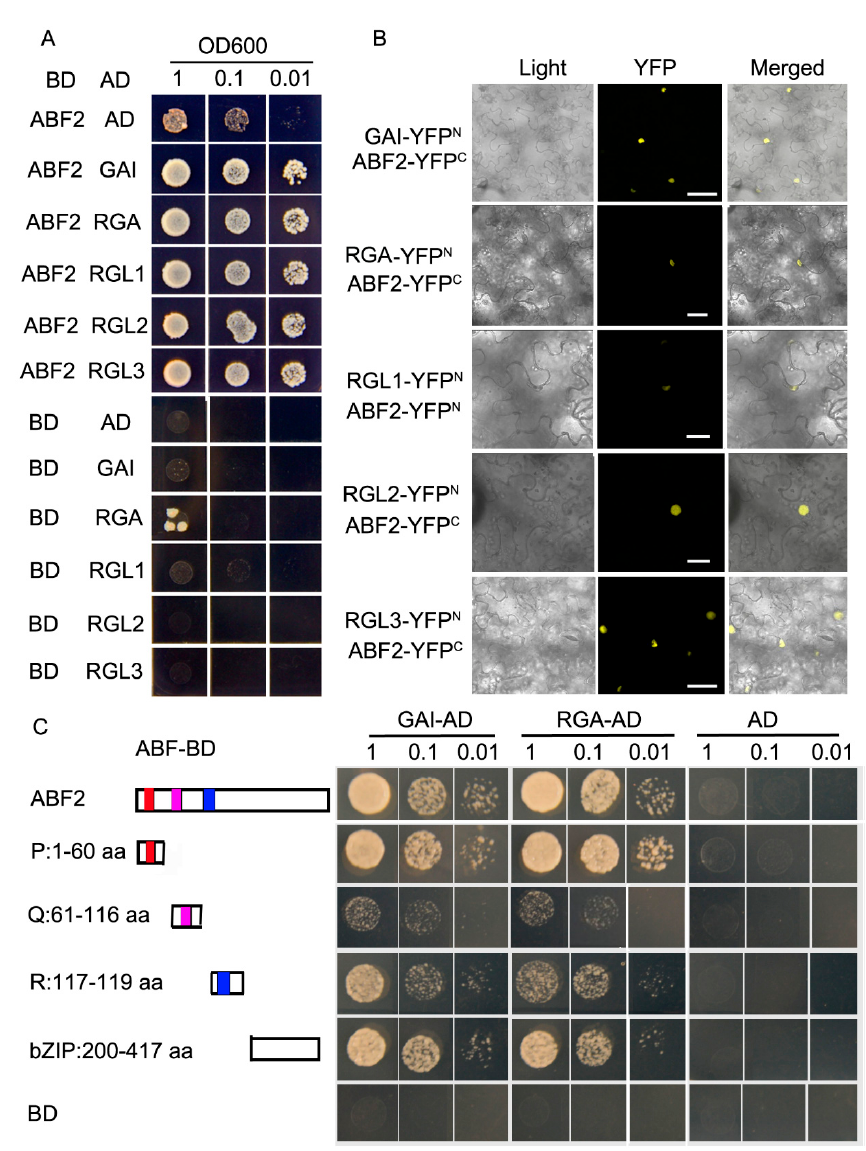
Figure 2. DELLA (GAI / RGA / RGL1 / RGL2 / RGL3) proteins interacted with ABF2 (abscisic acid (ABA)-responsive element (ABRE)-binding transcription factors). ( A ) DELLA proteins interacted with ABF2 in yeast two-hybrid assay. The yeast cells expressing the indicated constructs were spotted as a series of three dilutions. The yeast cells expressing the constructs of ABF2-pGBKT7-DEST (BD) / GAI-pGADT7-DEST (AD), ABF2-BD / RGA (REPRESSOR OR GAI3)-AD, ABF2-BD / RGL1 (RGA-LIKE1)-AD, ABF2-BD / RGL2-AD, and ABF2-BD / RGL3-AD grew better on the SD medium than that of yeast growth cells expressing the control’s constructs. ( B ) BiFC (bimolecular fluorescent complimentary) assay between DELLA proteins and ABF2. Nicotiana benthamiana leaves were co-transformed with the constructs containing the indicated YFP (yellow fluorescent protein) N-terminal (YFP N ) and YFP C-terminal (YFP C ) fusions, and YFP was imaged 48 h after transformation. Bars = 50 µ m. ( C ) Interaction assay between GAI and RGA with ABF2 fragments. P: 1–60 amino acid; Q: 61–116 amino acid; R: 117–199 amino acid; bZIP (basic region / leucine zipper): 200–417 amino acid. The yeast cells expressing the indicated constructs were spotted as a series of three dilution. The yeast cell expressing the constructs of ABF2-BD / GAI-AD, ABF2-BD / RGA-AD, ABF2P-BD / GAI-AD, ABF2P-BD / RGA-AD, ABF2bZIP-BD / GAI-AD, ABF2bZIP-BD / RGA-AD, grew more e ff ectively on the SD medium than that of yeast cells expressing ABF2R-BD / RGA-AD, ABF2R-BD / GAI-AD, ABF2Q-BD / RGA-AD, and ABF2Q-BD /